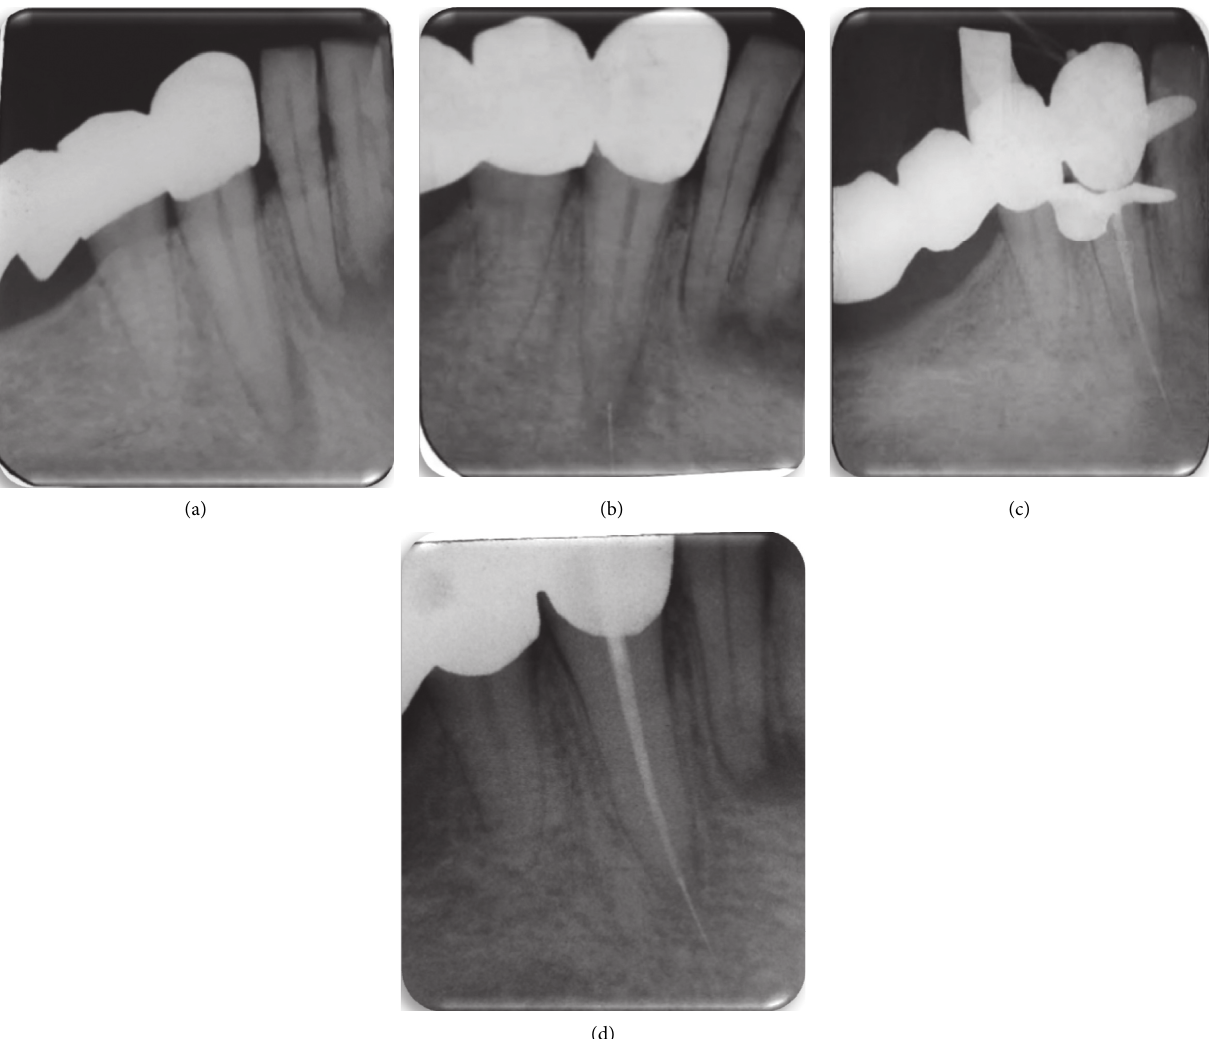
Figure 2: A case of a healed lesion: (a) preoperative radiograph; (b) radiograph showing the fracture of the K20 file; (c) postoperative radiograph; and (d) a 6-month follow-up radiograph.